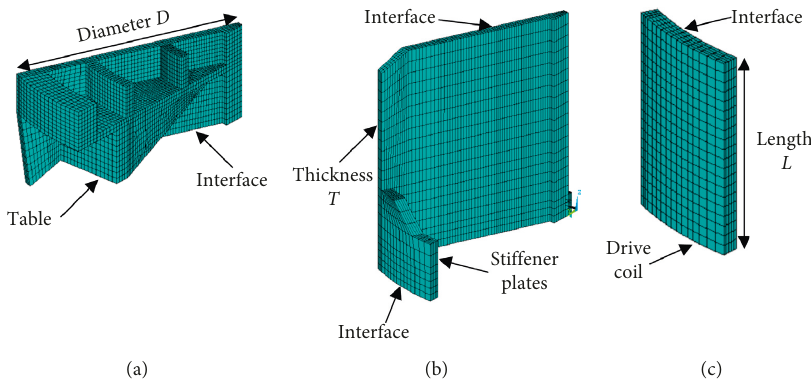
Figure 3: The interfaces and shape parameters of the substructures. (a) Substructure 1. (b) Substructure 2. (c) Substructure